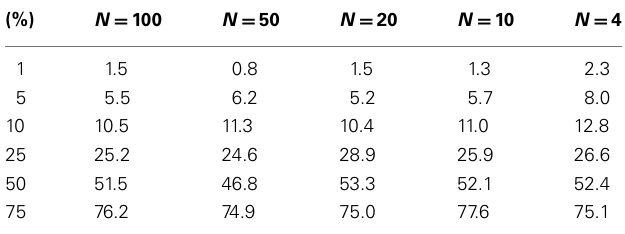
FIGURE 4 | Scatter plot of p -values obtained from the F -distribution vs. permutation tests for random samples sizes varying between 4 and 100 (i.e., 4 ≤ N ≤ 100) and random variables size from 1 to 100 (i.e., 1 ≤ P ≤ 100) with a single continuous regressor variable ( M = 1) simulated 1000 times. Outlying observations represented as black squares lying away from the trend line have sample sizes less than or equal to eight. 100 variables had increments of 0.001 added to them for the